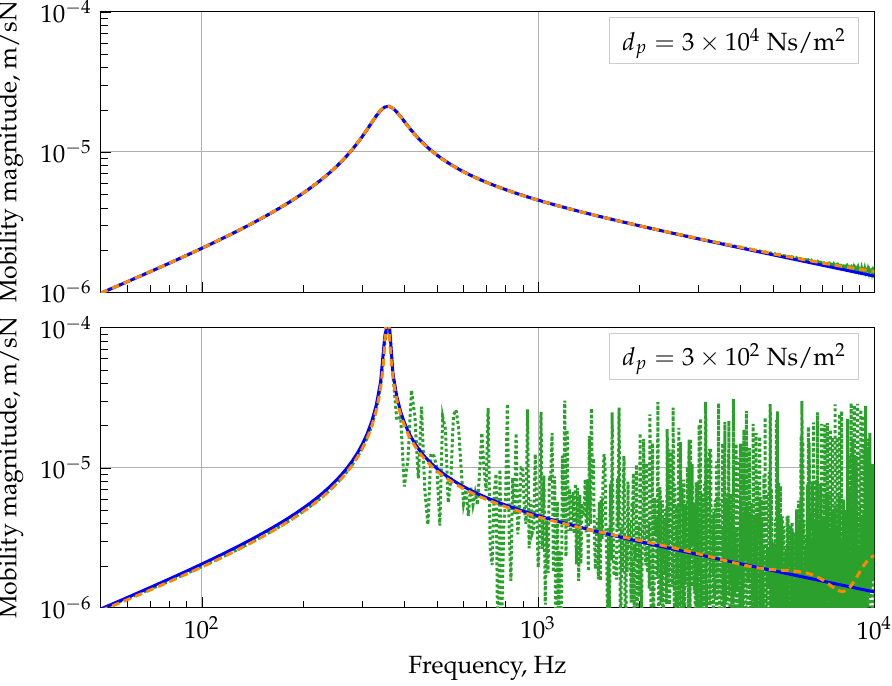
Figure 11. Point mobility of an undamped infinite beam on a continuous single-layer support. Analytical mobility (25), with boundary domains, without boundary